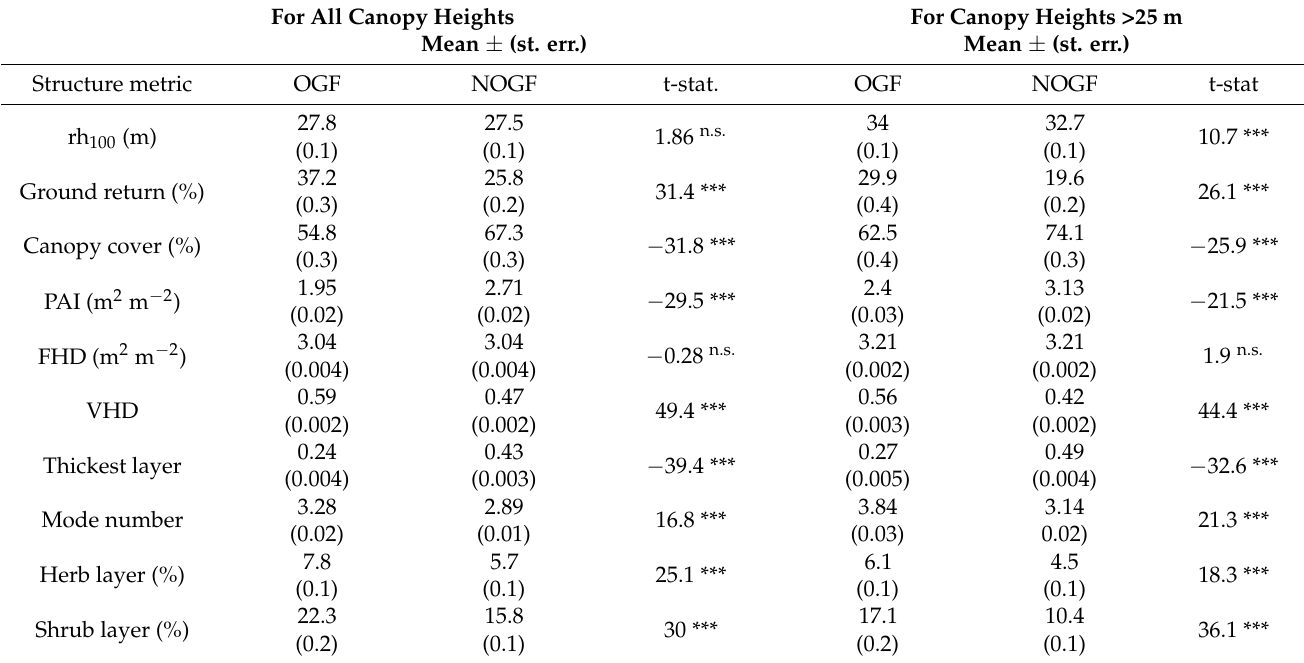
Figure 7. Boxplots of structural metrics (see Table 1) for old-growth forest (OGF) and non-OGF (NOGF) for canopy height of over 25 m. We show broadleaf (B), conifer (C) and mixed (M) forest structure. The thickest layer metric is given as a fraction of canopy height (m), and both the herb layer and shrub layer as fractions of aboveground return. PAI is plant area index, FHD is foliage diversity index and VHD is vertical distribution index. Table 2. Structural variables for old-growth forest (OGF) and non-OGF (NOGF) conifer stands for all canopy height values and for canopy height values over 25 m. The t-stat column shows t-value, as well as significance in superscript: n.s. is not significant, while *** indicates significance at 0.001 level. St. err. stands for standard error of the mean and is shown in brackets below the mean